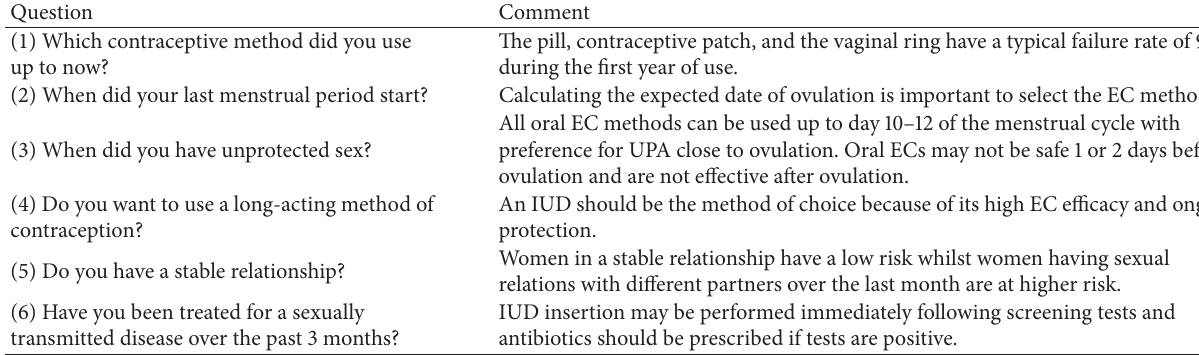
Table 2: Short questionnaire to help select the EC method for the individual patient.